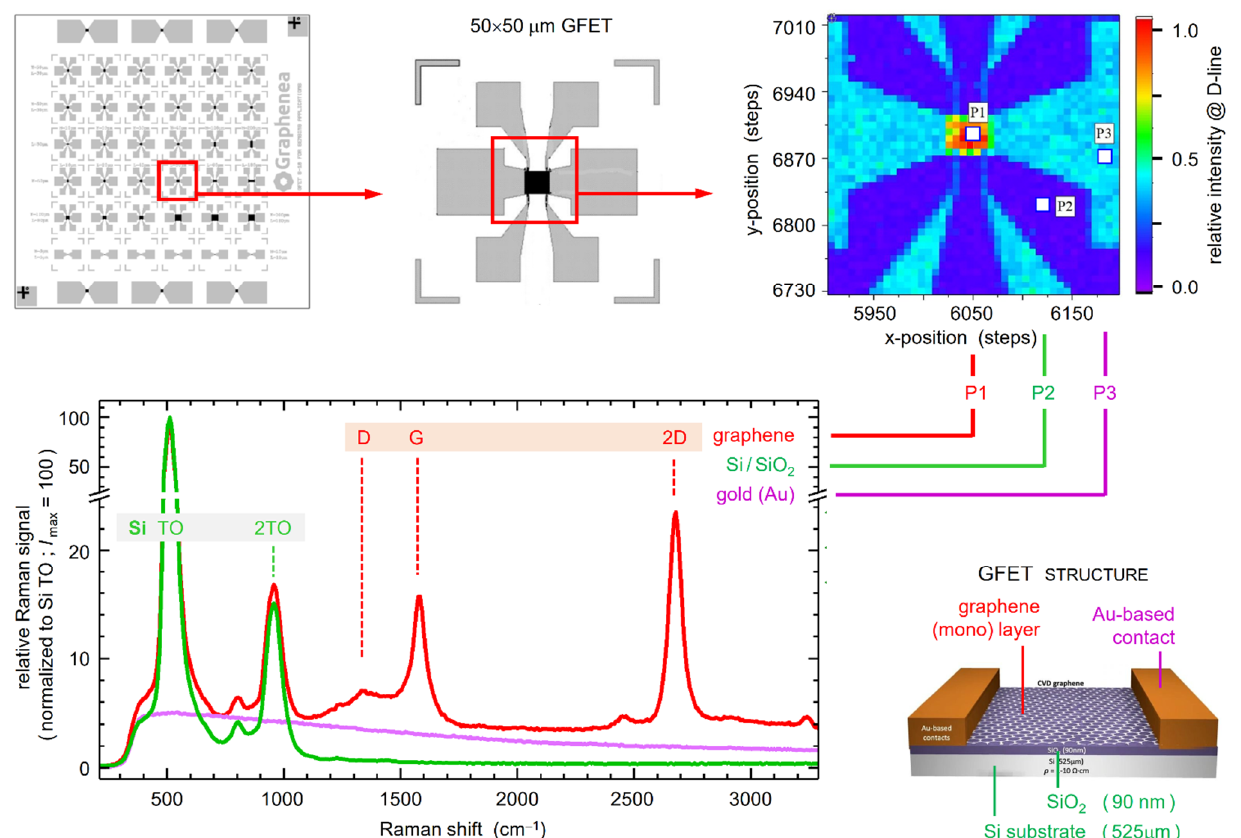
Figure 3. Concept of Raman spectral mapping, exemplified for a graphene sample (GFET-S10, Graphenea ; image reproduced with permission), with the recorded data related to the indicated 50 × 50 μm 2 GFET device. The area is raster-scanned (here with a step-increment of ΔS = 7 (equivalent to ~9 μm)), with a sequence of full spectra recorded at each raster point. Out of the hyperspectral stack, a particular slice is selected to generate a Raman map of the sample (here for the data at about 1330 cm −1 ). Selected spectra from three specific locations in the GFET structure—graphene layer, gold-contact, and substrate (marked by the white squares)—are displayed in the lower left, highlighting the distinct spectral differences associated with the (chemical) sample constituents. For further details, see text.